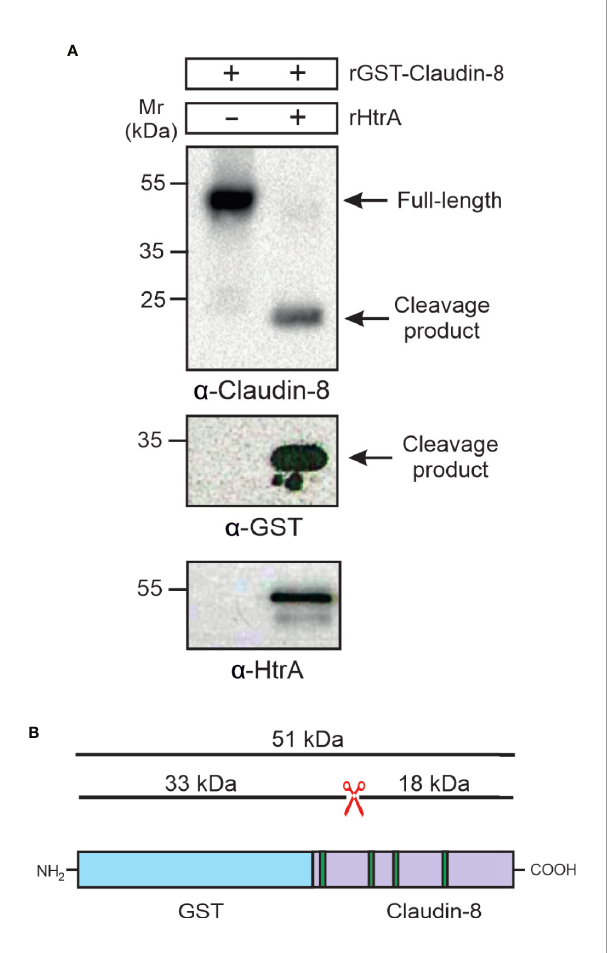
FIGURE 5 | HtrA cleaves claudin-8 in a cleavage assay in vitro . (A) Recombinant GST-tagged human claudin-8 was incubated with either puri fi ed rHtrA in vitro . Immunoblotting against a -claudin-8 showed cleavage of the full-length GST-tagged claudin-8 protein, when incubated with recombinant HtrA resulted in the appearance of an 18-kDa claudin-8 fragment. In addition, a cleaved 33-kDa fragment was visualized in the blot with a -GST antibodies. (B) Mapping of the GST-claudin-8 cleavage fragments. The full-length GST-tagged claudin-8 protein (51 kDa) is cleaved into a carboxy-terminal 18-kDa fragment of claudin-8 and a 33 kDa amino- terminal fragment containing the GST-tag and the remaining 8-kDa amino- terminal fragment of claudin-8.